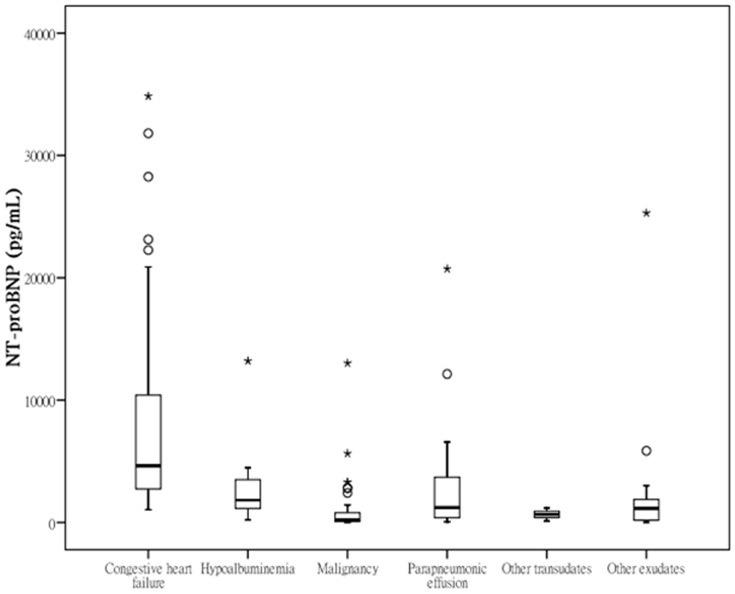
Boxplots showing the minimum, 25th, 50th, and 75th percentiles, and the maximum pleural N-terminal pro-B-type natriuretic peptide (NT-proBNP) levels, by etiologies of pleural effusions.Outliers (open circles) and extremes (stars) are plotted separately.